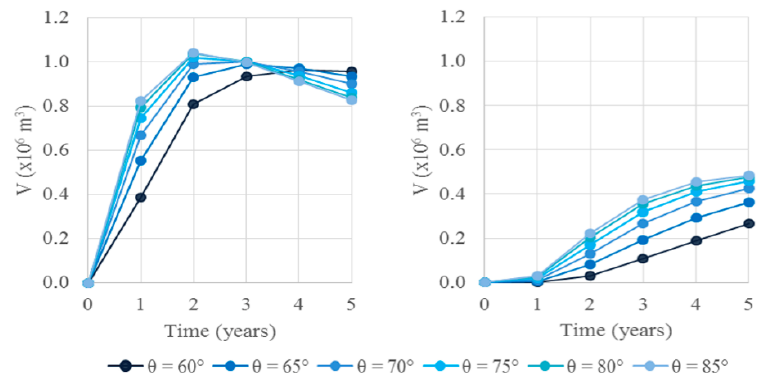
Figure 12. Nourishment volumes’ distribution in time (H = 3 m; Ext/Ext): Stretch 8 ( left ) and stretch 7 ( right ).